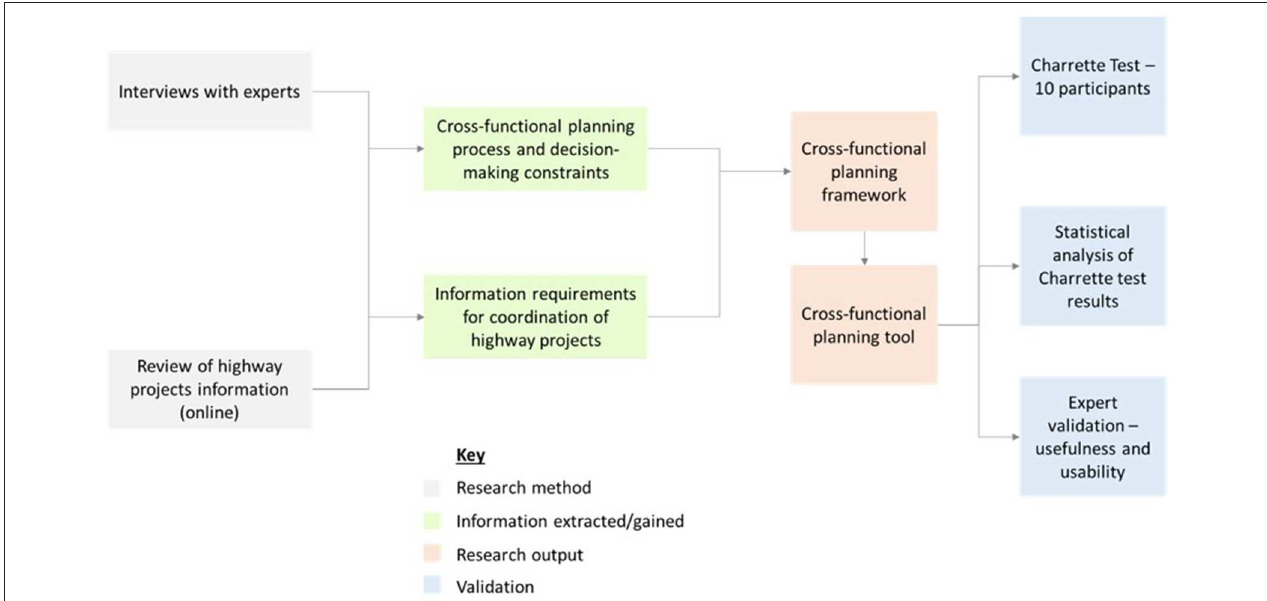
FIGURE 2 | Research approach to